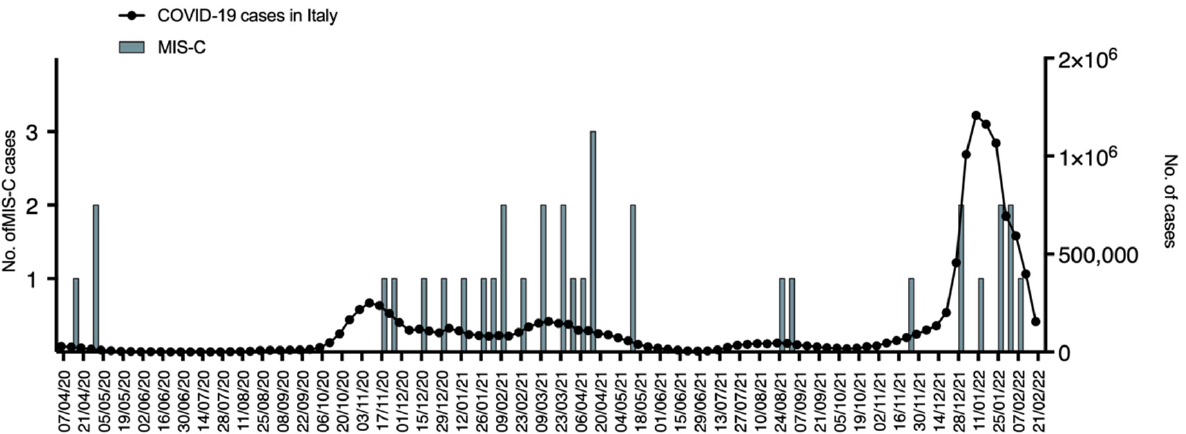
Figure 5. Line with dots represents the median number of COVID-19 cases for each week in Italy and green bars the median number of MIS-C infections for each week. green bars the median number of MIS-C infections for each week.